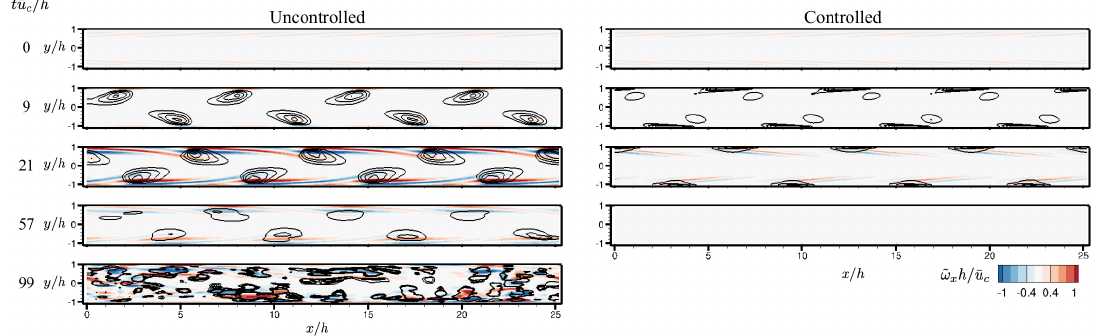
Figure 15. A comparison of instantaneous streamwise vorticity ˜ ω x h / ¯ u c flow fields at slice z / h = 0 between uncontrolled and controlled cases with ( α , β ) = ( 1,1 ) and E 0 = 0.5 lines denote -criterion in a range of 0.01 Q